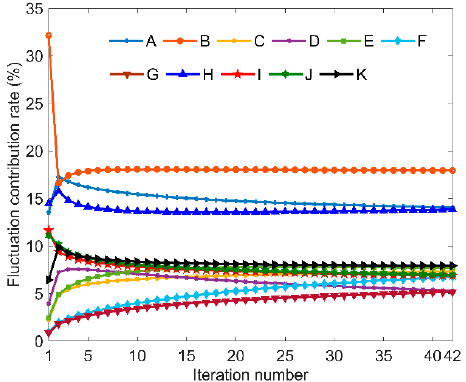
Figure 9. Variation of fluctuation contribution rates.